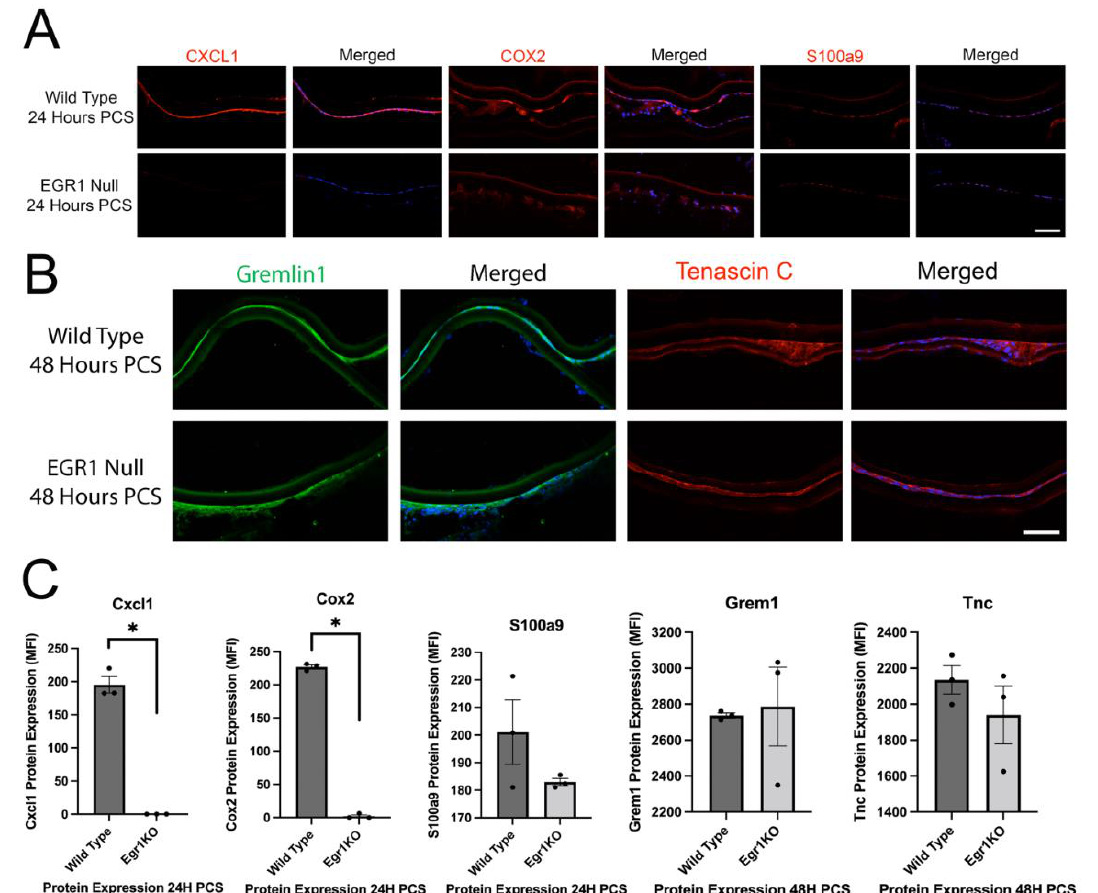
Figure 6. Egr1KO LECs attenuate a portion of their inflammatory response PCS but the fibrotic response was not affected. ( A ) Immunofluorescence analysis of the proinflammatory mediators Cxcl1, Cox2 and S100a9 (red) in LECs from wild type and Egr1KO mice at 24 h PCS. Blue = DNA, Scale bar = 70 μ m. ( B ) Immunofluorescence analysis of the fibrotic markers Gremlin1 (green) and Tenascin C (red) in LECs from wild type and Egr1KO mice at 48 h PCS. Blue = DNA, Scale bar = 70 μm. ( C ) Quantitation of the data shown in panels A and B. Cxcl1 and Cox2, * represents p ≤ 0.01; S100a9, p = 0.26; Gremlin 1, p = 0.84; Tenascin C, p = 0.42. The black dots in C represent the individual biological replicates for each bar in the bar graph.